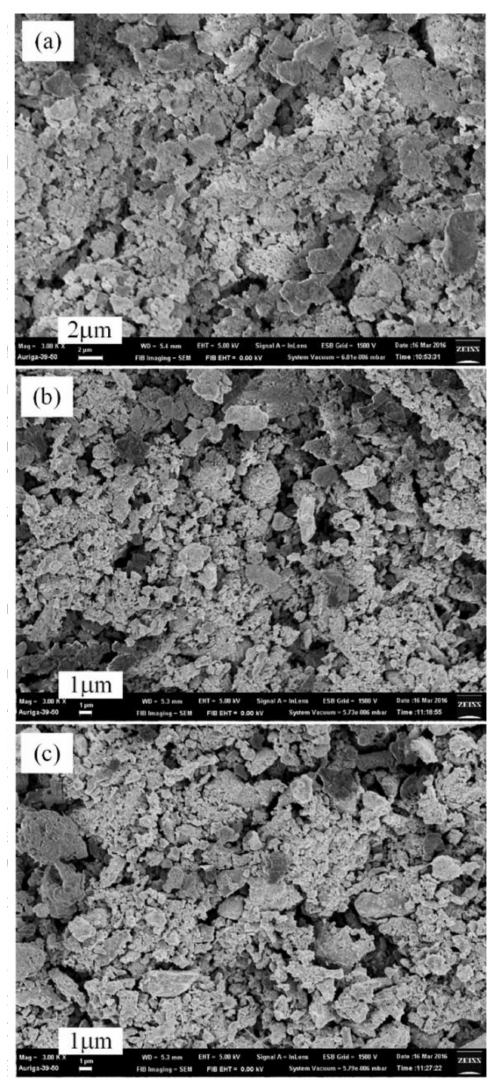
Figure 9. Comparisons of surface characteristics (10,000 × ) ( a ) original Al powders, ( b ) powders prepared by thermal nitridation at 850 ◦ C and Al/NH 4 Cl = 1/1, ( c ) powders produced by plasma nitridation at 550 ◦ C, 1.2 kW for 2 min and Al/NH 4 Cl =